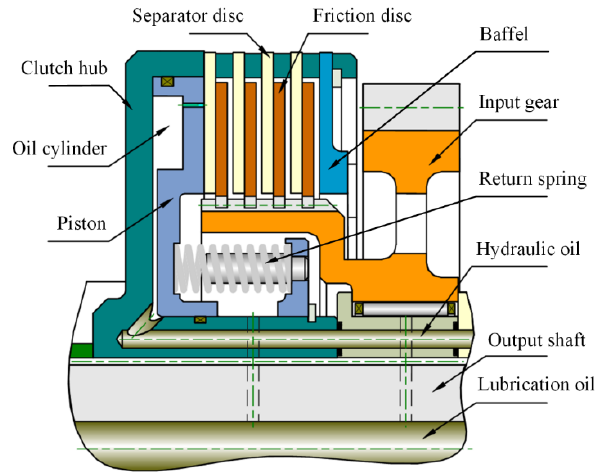
Figure 1. Structure of the wet multi-disc clutch.